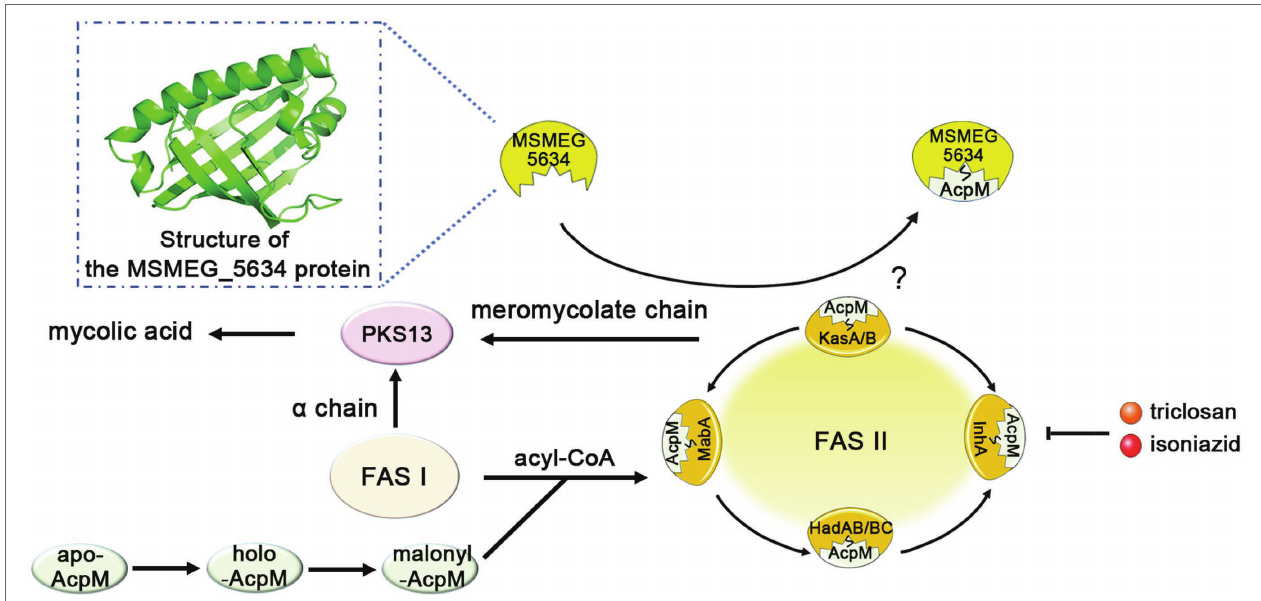
FIGURE 8 | A model depicting the structure and function of MSMEG_5634. MSMEG_5634 was determined to be a helix-grip structure protein with a deep hydrophobic pocket, preferring to form a complex with acyl-AcpM containing a fatty acyl chain at the C36-52 length, which is the medium product of FAS-II. MSMEG_5634 can interact with FAS-II components and transport acyl-AcpM away from FAS-II by forming the MSMEG_5634/acyl-AcpM complex, which is free from FAS-II. MSMEG_5634 contributes to the susceptibility of the drugs targeting FAS-II. Deletion of the MSMEG_5634 gene in Mycobacterium smegmatis leads to the tolerance to isoniazid and triclosan, two inhibitors of the FAS-II system. The question marker indicates the impact of MSMEG_5634 on FAS-II activity, especially under stress conditions, remains to be further